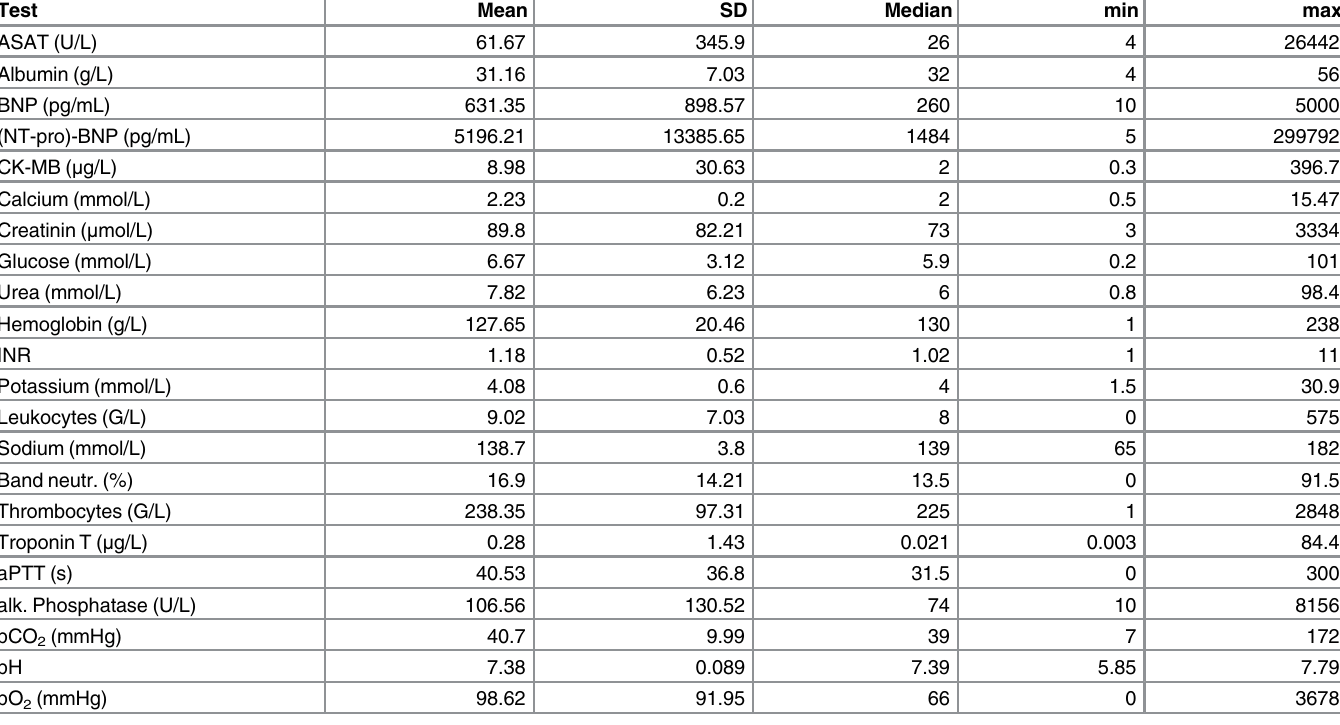
Table 1. Laboratory test results descriptive statistics for all